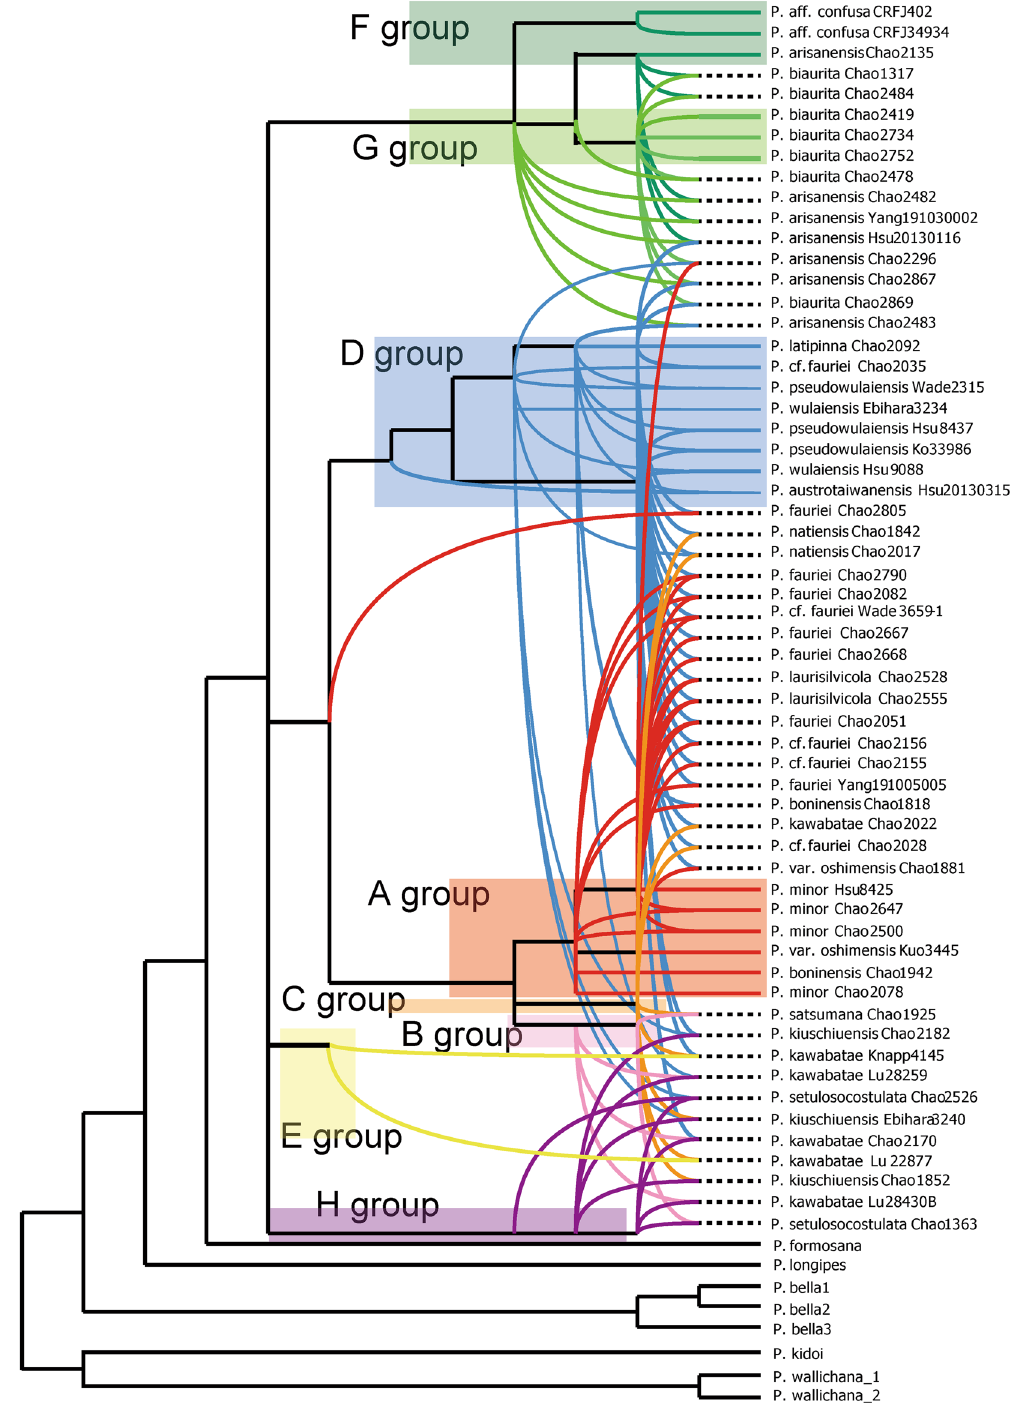
Figure 4. Phylogenetic network of the Pteris fauriei group, based on Knox3 gene. Color of line indicates lineage of Knox3 grouping. A group in red; B group in light purple; C group in orange; D group in yellow green; E group, in blue; F group in green; G group in limon. The dash black lines mean hybrid taxa. The taxa correspond to samples in Table